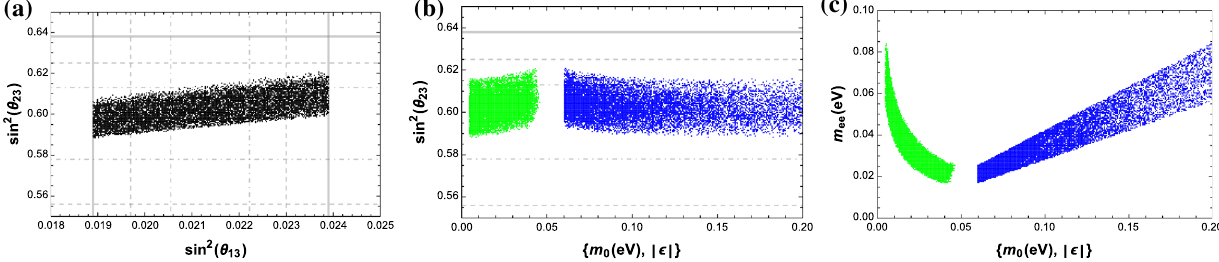
(cid:27) (cid:27) (cid:27) m (cid:27) and | (cid:17) | , respectively. The dot-dashed, dashed and thick lines stand for 1 σ , 2 σ and 3 σ of C.L. ν 3